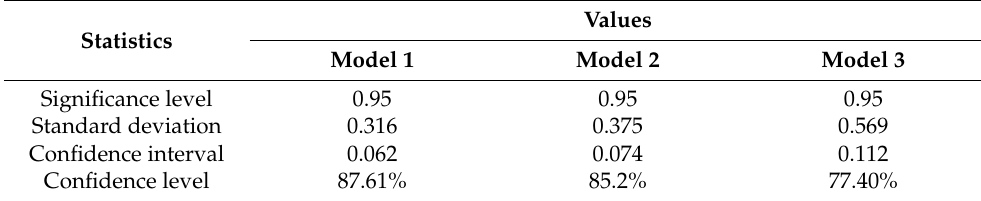
Table 8. Confidence estimation of prediction